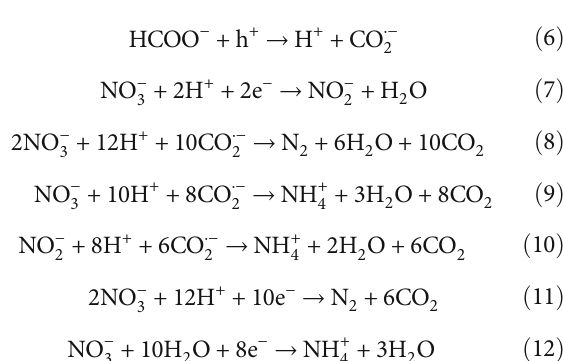
photocatalyst and (b) 1.0%Ag-TiO 2